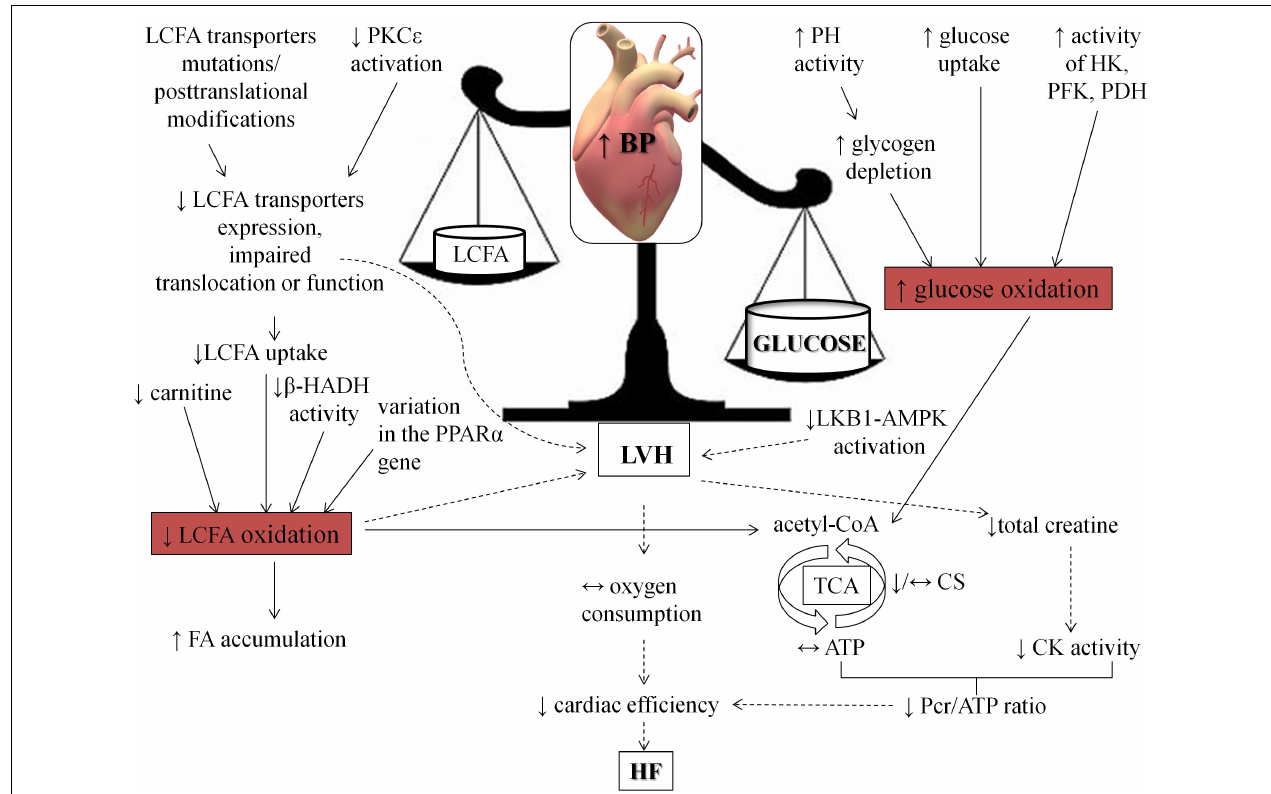
FIGURE 3 | Consequences of hypertension on heart metabolism and function. The figure shows how hypertension shifts fuel preference from fatty acids toward carbohydrates. AMPK, AMP kinase; β -HADH, β -hydroxy-acyl-CoA dehydrogenase; CK, creatine kinase; CS, citrate synthase; HF, heart failure; HK, hexokinase; LKB1, liver kinase B; LVH, left ventricle hypertrophy; Pcr, phosphocreatine; PDH, pyruvate dehydrogenase; PFK, phosphofructokinase; PH, phosphorylase; PKC ε , protein kinase C ε ; PPAR α , peroxisome proliferator-activated receptor alpha.